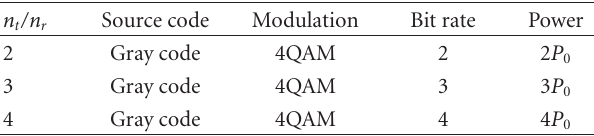
Table 1: Configurations of the